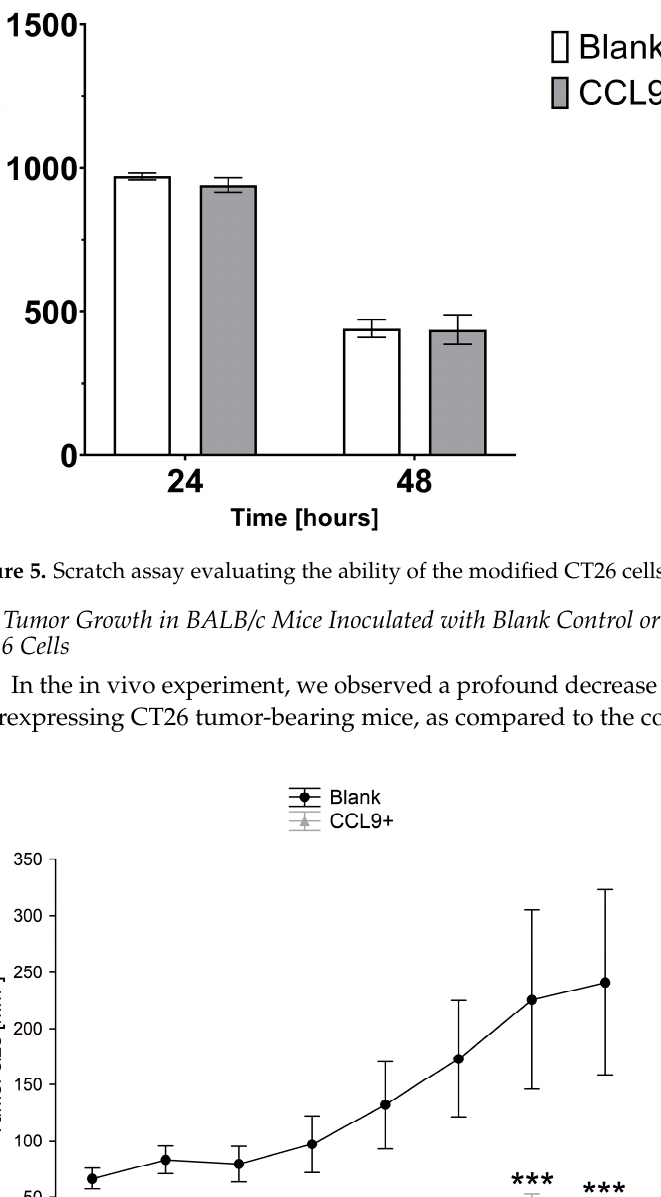
Figure 4. Migration of the unmodi fi ed CT26 cells upon the in fl uence of the media collected from 48- h cultures of blank control or CCL9-overexpressing CT26 cells. Migration of the modi fi ed cell lines was also assessed in scratch assays (Figure 5).